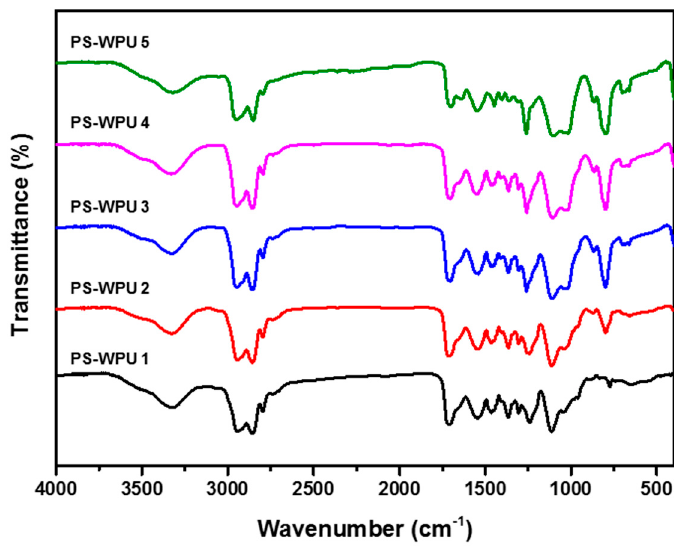
Figure 1. FTIR spectra of PS − WPU